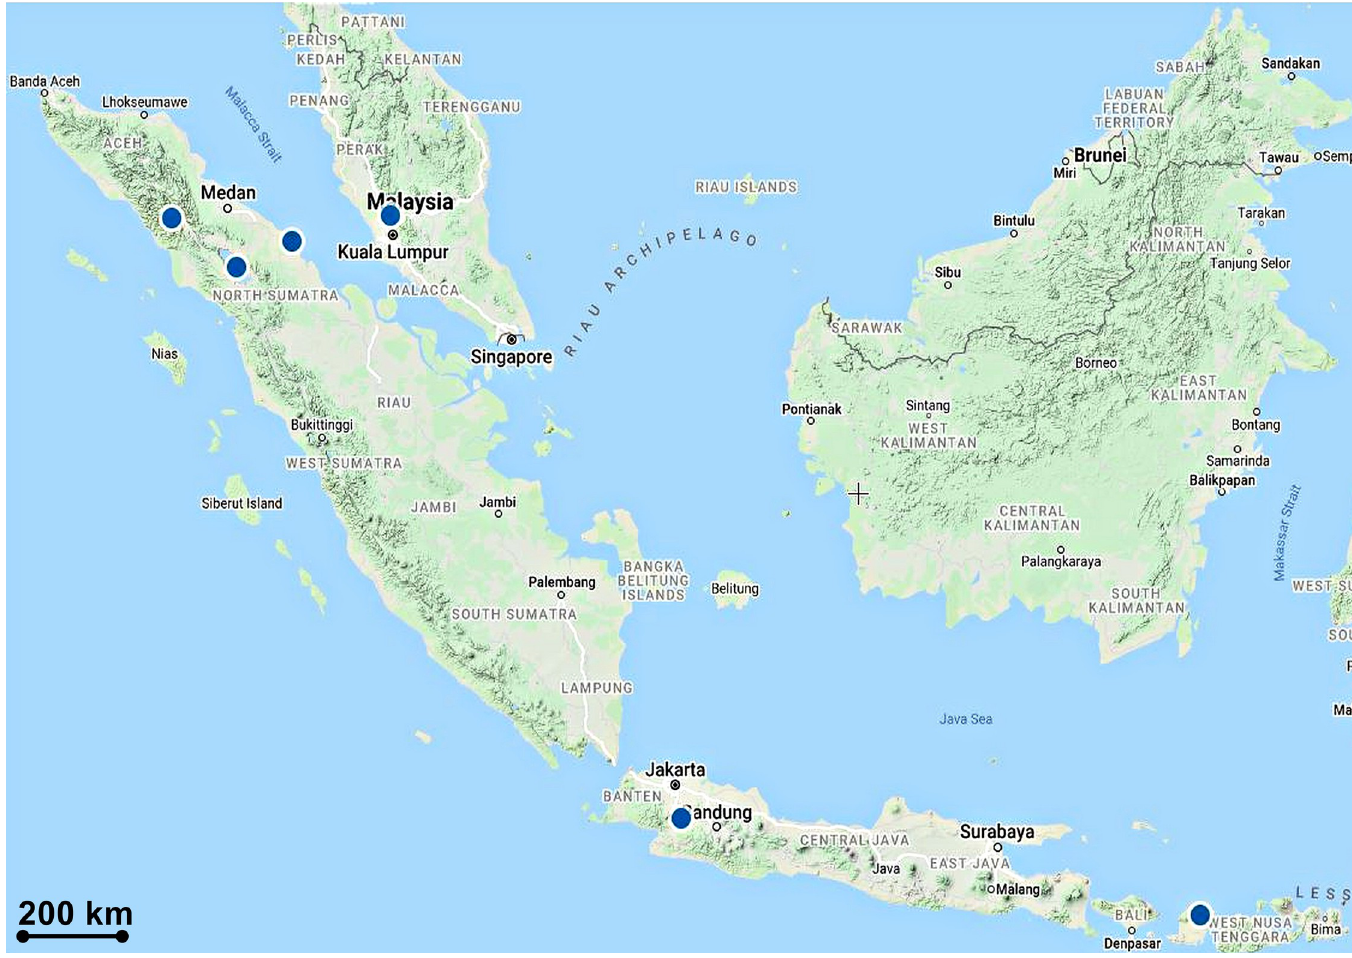
Fig 5. Distribution of Calanthe chrysoglossoides